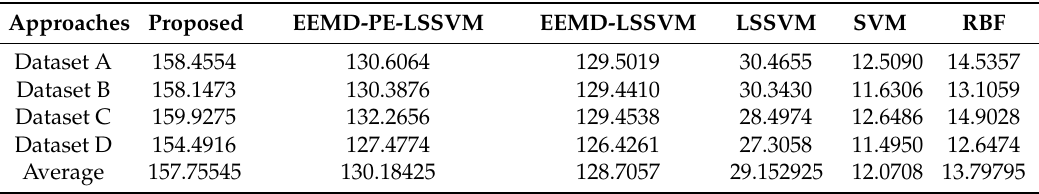
Table 8. The simulation time for all